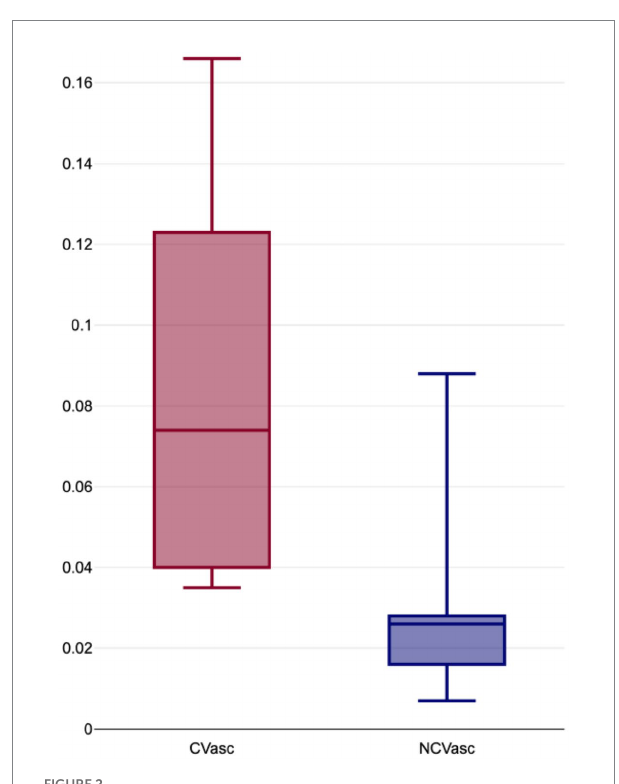
FIGURE 2 Boxplot distribution of proportion of vascular volumes within COVID-19 affected lung volumes (C Vasc ) and normal lung volumes (NC Vasc